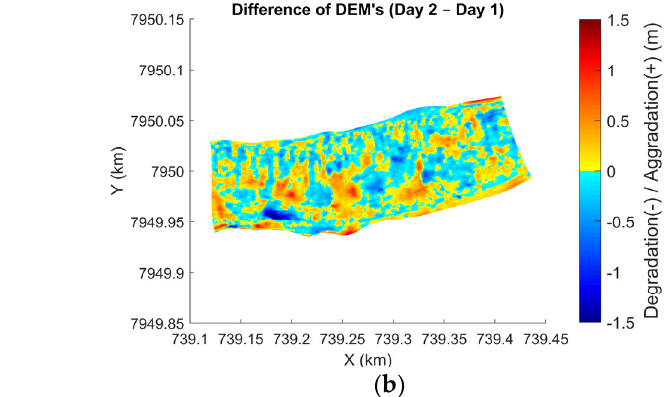
Figure 9. ( a ) Underwater DEM (1 February 2018) of the region where the modified ISSDOTv2 method was applied; ( b ) difference of DEMs showing regions of aggradation (+) and degradation ( − ) between the surveys.